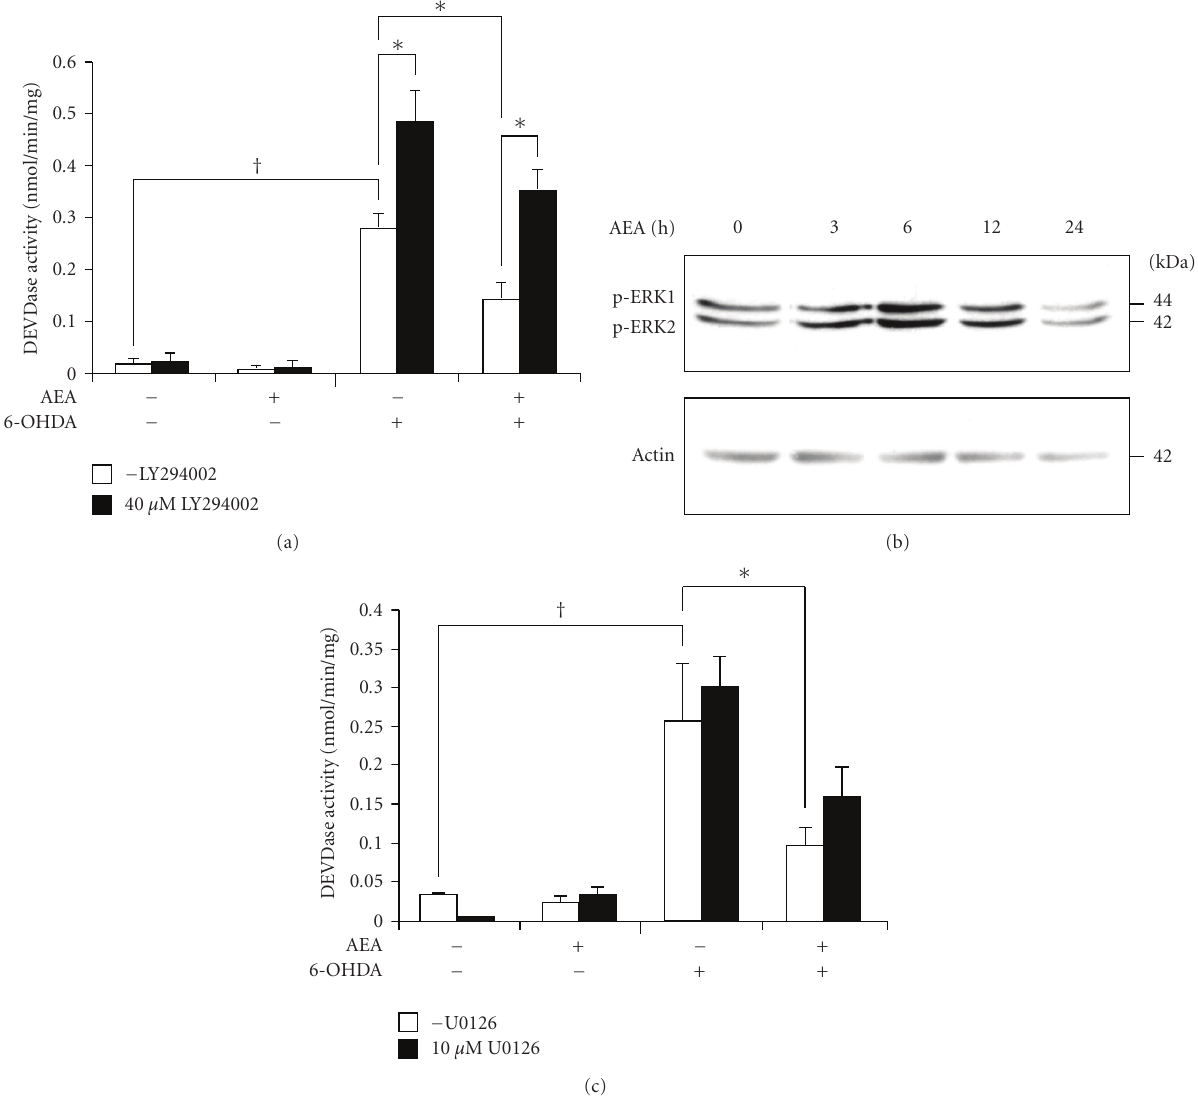
Figure 4: Role of PI3K and MAPK signalling in anandamide-mediated protection against 6-OHDA toxicity. (a) PC12 cells were pre-treated with 40 μ M LY294002 for 1 hours prior to addition of 25 μ M anandamide for 24 hours followed by treatment with 100 μ M 6-OHDA for a further 24 hours. Values represent the mean ± SEM of 4 independent experiments. ∗ P < . 005, P † < . 001 . (b) PC12 cells were treated with 25 μ M anandamide for 0–24 hours. The phosphorylation state of ERK1/2 was analysed by Western blotting. Actin protein levels were also analysed as a loading control. The results are representative of two separate experiments. (c) 10 μ M U0126, the MAPK pathway inhibitor was added 1 hour prior to incubation of PC12 cells with 25 μ M anandamide for 24 hours and with 100 μ M 6-OHDA for a further 24 hours. Values xrepresent mean ± SEM of three independent determinations. P † < . 001, ∗ P < . 01